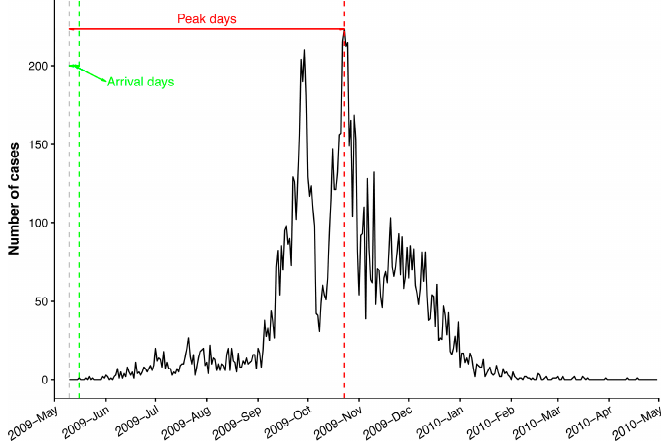
Figure 2. Illustration of arrival days and peak days using the daily epidemic curve of confirmed cases in Beijing. The gray, green, and red vertical dashed lines represent, respectively, the date of the first case in mainland China (10 May 2009), the date of the first case in Beijing (16 May 2009), and the date with the highest incidence in Beijing (23 October 2009).